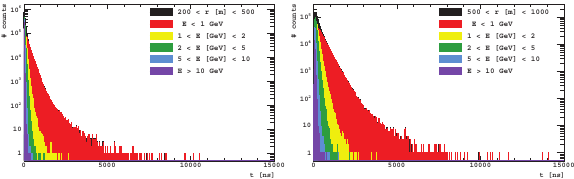
Figure 4. Arrival time distribution of muons arriving at 200 < r [m] < 500 (left) and 500 < r [m] < 1000 (right). The colors represent several ranges for the initial energy muons, namely: black – all energies; red – E i < 1 GeV; yellow – 1 < E i [GeV] < 2; green – 2 < E i [GeV] < 5; blue – 5 < E i [GeV] < 10; violet – E i > 10